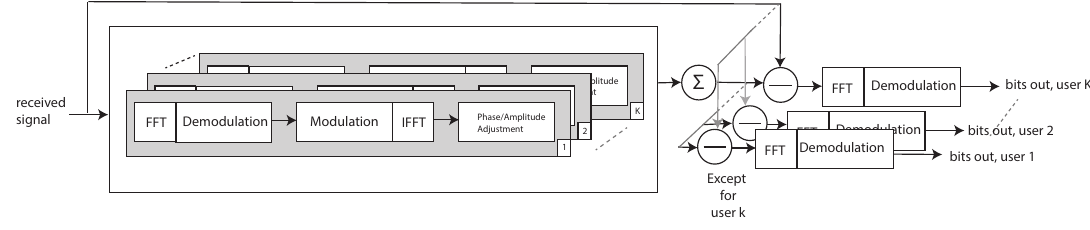
Figure 2. Block diagram of a typical parallel interference cancellation